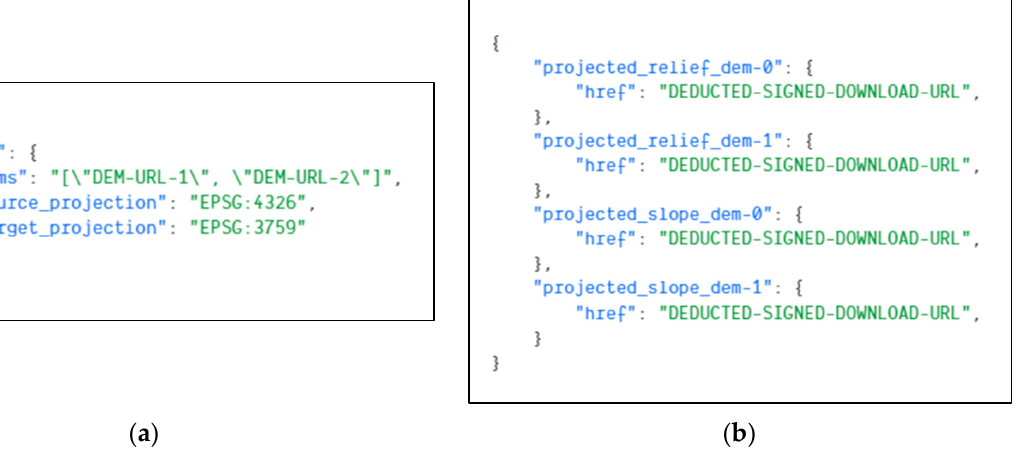
Figure 15. HTTP request payload to execute the sample workflow ( a ) Workflow execution response body that has generated signed URLs to download output raster files ( b ).